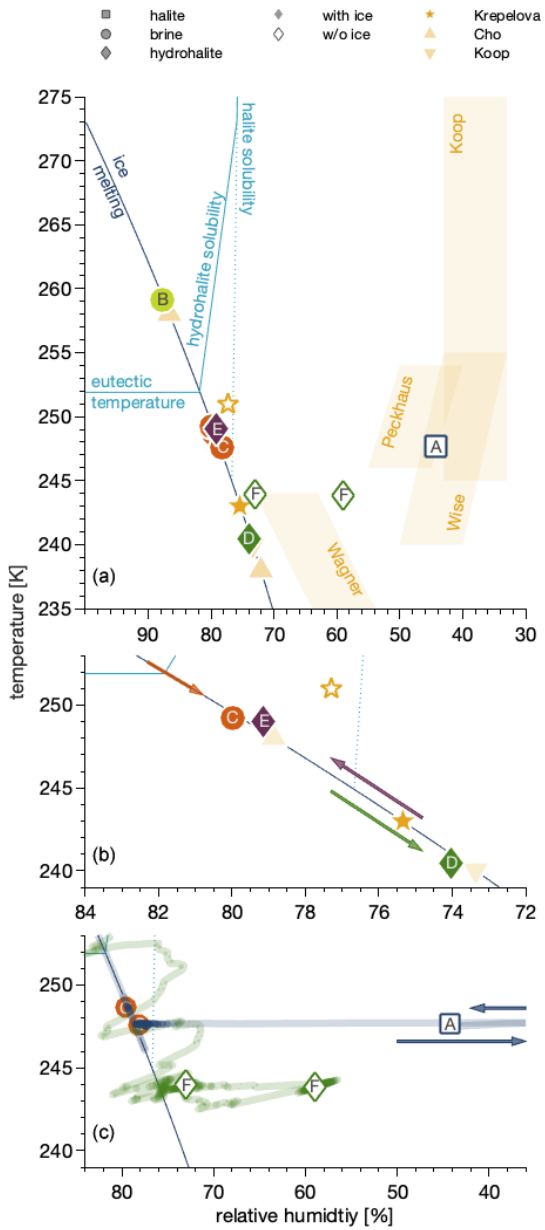
Figure 4. Phase diagram of the sodium chloride–water binary system showing the conditions and trajectories of the data in Fig. 3 in the relative humidity–temperature space. The relative humidity is the partial pressure of water relative to the vapour pressure of (supercooled) water as parameterized by Marti and Mauersberger (1993). The dark-blue line denotes settings where ice is stable as the partial pressure of water matches the vapour pressure of ice. Above the eutectic temperature, it thus separates regions where ice and NaCl solution co- exist from those where only NaCl solutions exist. The light-blue lines denote conditions where anhydrous NaCl salt (“halite solubility”) (cid:113) and where NaCl 2H 2 O (“hydrohalite solubility”) form a solution when increasing the relative humidity at constant temperature and where (cid:113) NaCl 2H 2 O dissolves with increasing temperature at a constant relative humidity (“eutectic temperature”). (a) Data from this work compared to previous results (Krepelova et al., 2010a; Cho et al., 2002; Koop et al., 2000a). Also shown, as shaded areas, are the data ranges where efflorescence has been observed in earlier work (Koop et al., 2000a; Wagner et al., 2011; Wise et al., 2012; Peckhaus et al., 2016). (b) Enlarged view of data below the eutectic temperature. The arrows show the sequence of changes in experimental temperature and relative humidity conditions. (c) Enlarged view of the data in the absence of ice. The lines indicate the relative humidity and temperature trajectories to reach the experimental conditions for these data points. The arrows illustrate that the relative humidity was reduced to 0% prior to returning to the conditions of the